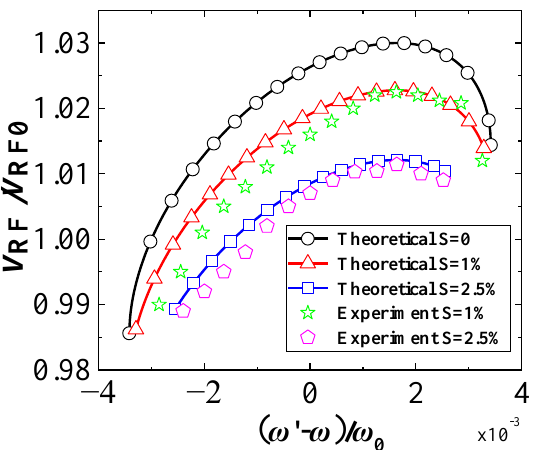
Figure 5. Experimental and theoretical injection locking performance with respect to the power supply ripple S.